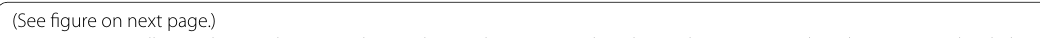
figure on next Fig. 5 SOX2OT alleviated DN pathogenesis by regulating Akt/mTOR-mediated autophagy in STZ-induced DN mice. a Blood glucose, 24 h proteinuria, serum creatinine and blood urea nitrogen levels in DN mice after SOX2OT overexpression in the presence or absence of rapamycin. b Relative kidney weight in DN mice with SOX2OT overexpression in the presence or absence of rapamycin. c HE, Masson and LC3 staining of renal sections in DN mice in response to SOX2OT overexpression in the presence or absence of rapamycin. IHC staining detected fibronectin and collagen IV levels. Scale bar: 50 μm. d Western blot analysis was employed to determine p-Akt, Akt, p-mTOR and mTOR levels in the kidney of DN mice after SOX2OT overexpression in the presence or absence of rapamycin. e Western blot analysis of LC3II, LC3I, Beclin1 and p62 in the kidney of DN mice after SOX2OT overexpression in the presence or absence of rapamycin. f , g Expression levels of collagen IV, fibronectin, α-SMA, E-cadherin and N-cadherin were measured by western blot in the kidney of DN mice after SOX2OT overexpression in the presence or absence of rapamycin. GAPDH was used as a loading control in western blot analysis. Error bars indicate the mean SD of at least triplicate experiments. Rapa, rapamycin. ± *p < 0.05, **p < 0.01, ***p < 0.001, One-way-ANOVA followed by Newman-Keuls post hoc